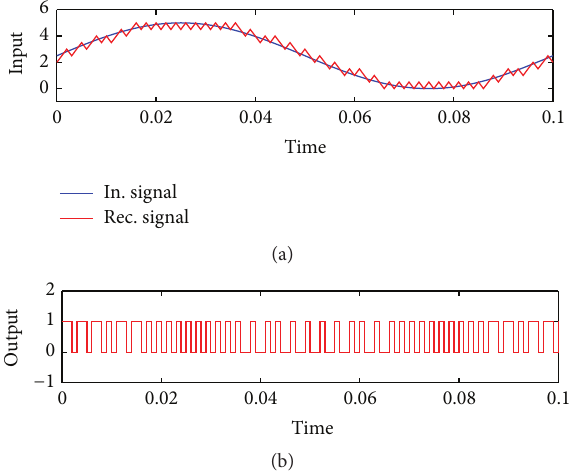
Figure 7: Delta modulation example of a sine input signal. (a) Input signal and reconstructed signal comparison. (b) Modulated